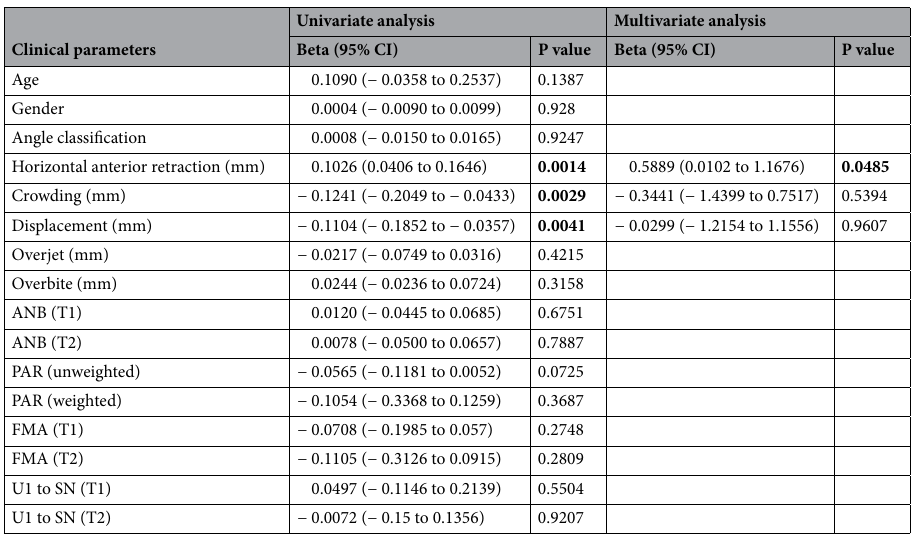
Table 1. Clinical parameters associated with orthodontic treatment duration. Simple (univariate) and multivariate linear regression analysis was used. Bold values denote statistical significance at the P < 0.05 level. CI Confidence interval, Beta Beta coefficient.